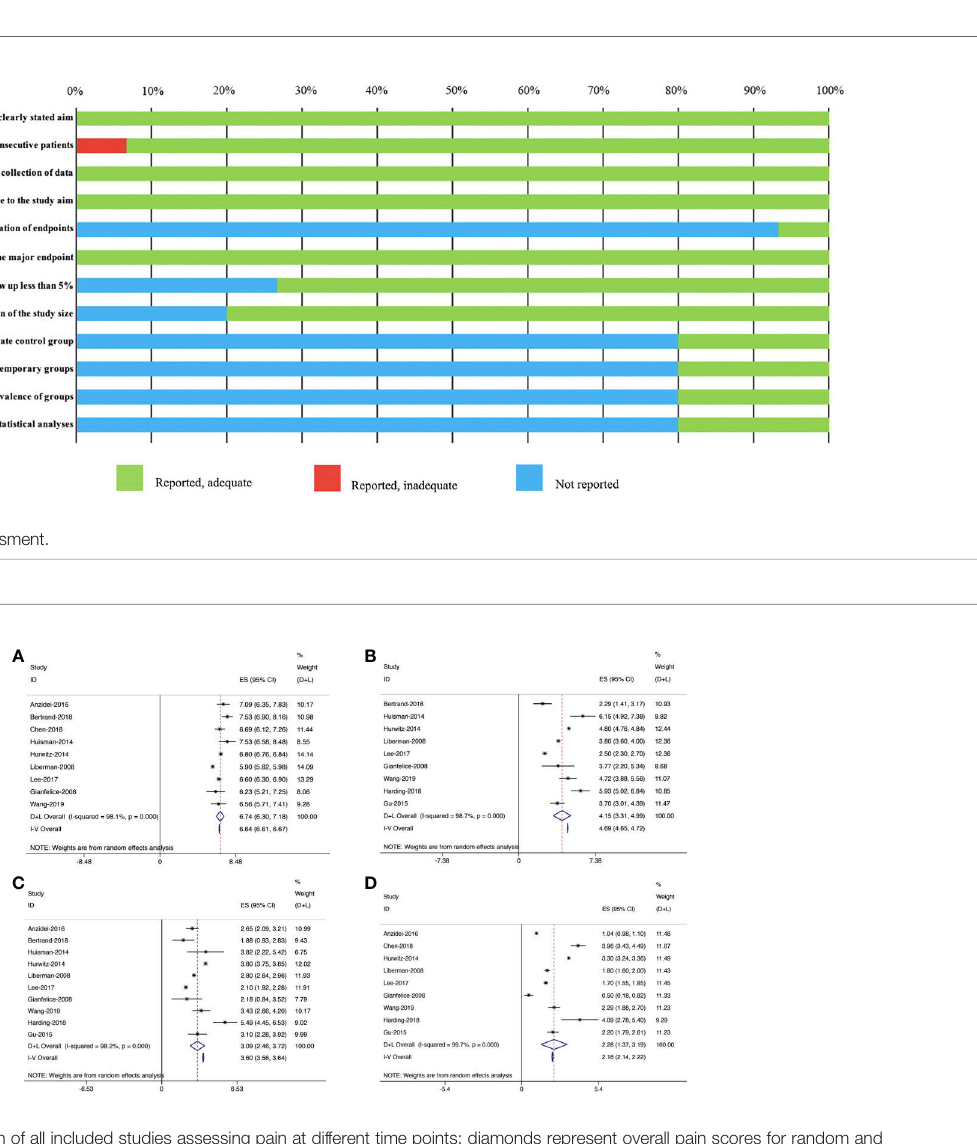
FIGURE 4 | Forest plot for inclusion of all included studies assessing pain at different time points; diamonds represent overall pain scores for random and fi xed effect models with 95% CI. (A) Pain assessment at baseline. (B) Pain assessment at 0 – 1 week. (C) Pain assessment at 1 – 5 weeks. (D) Pain assessment at 5 – 14